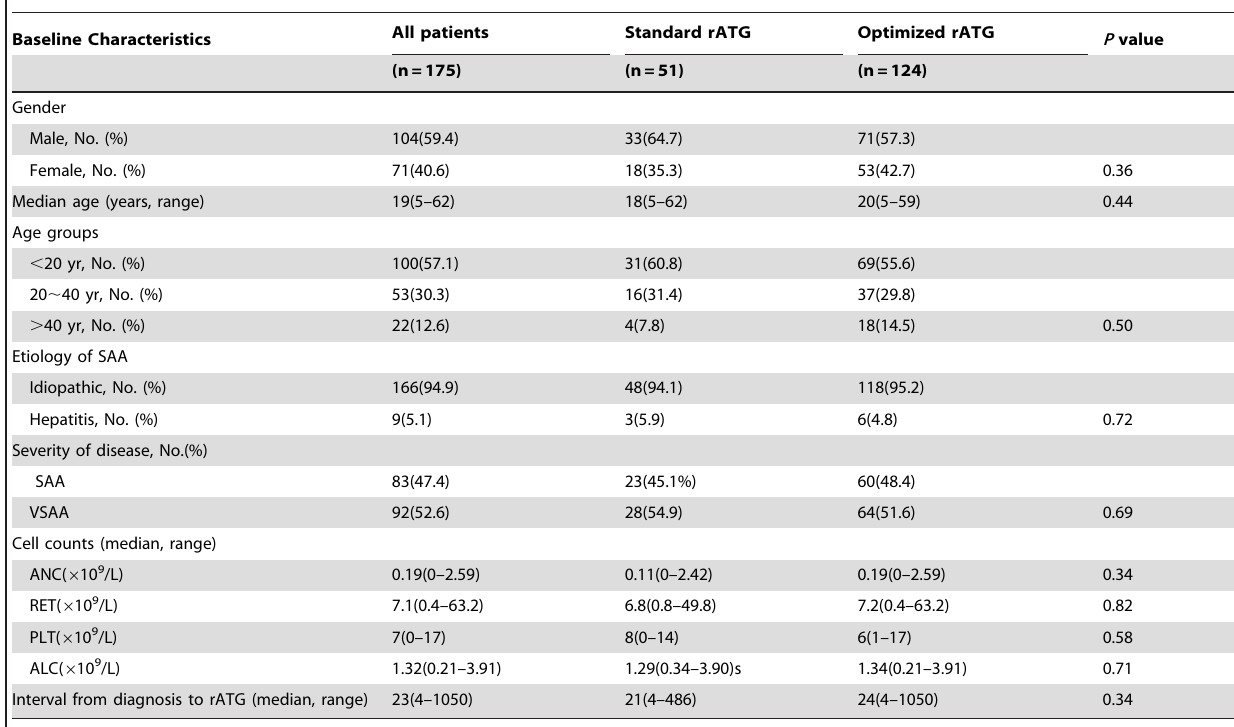
Table 1. Characteristics of the cohort of patients.